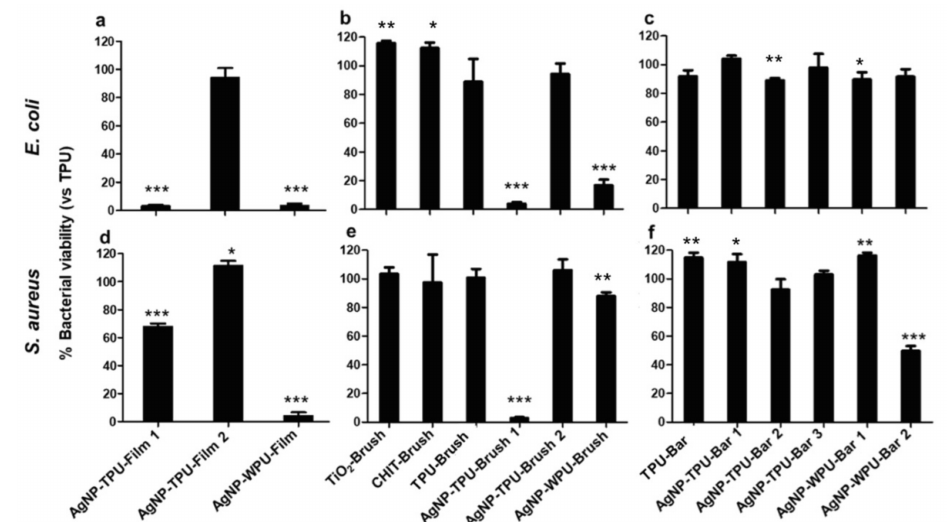
Figure 7. Cell viability on planktonic E. coli ( a – c ) and S. aureus ( d – f ) cultures after their removal from polymeric films (direct contact). After 24 h of incubation with TPU and WPU-deposited materials, both bacterial cultures were removed and cell viability evaluated by 3-(4,5-dimethylthiazol-2-yl)-2,5-diphenyltetrazolium bromide (MTT) test. The figure shows the percentage of viability of all 15 samples related to TPU set as 100%. Bars indicatemeanvalues ± SDofthemeanofresultsfromtwoexperiments. *-Student’s t -test,statisticalsignificance values were p < 0.05 (*), p < 0.01 (**) and p < 0.001 (***).